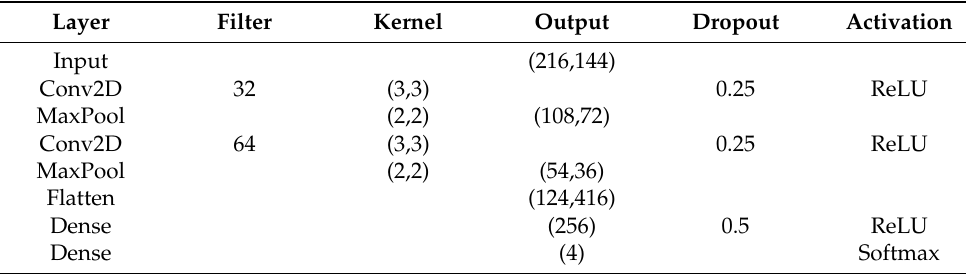
Table 1. CNN architecture for sleep-stage